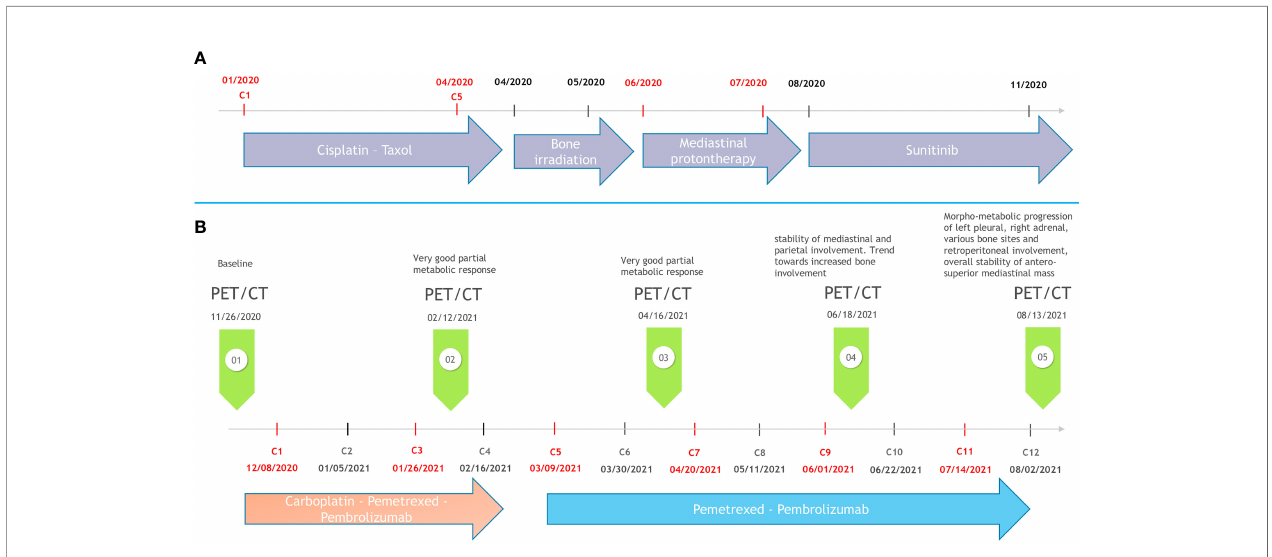
FIGURE 1 | Timeline of the disease course. (A) Previous treatment modalities. (B) Third metastatic line regimen with pembrolizumab plus